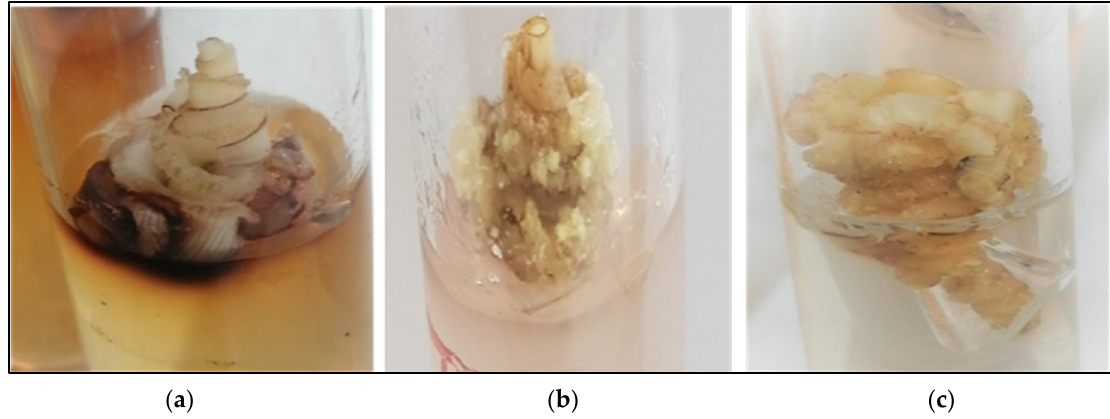
Figure 4. Callus of CP-77-400 on MS + 5 mg L − 1 2,4-D after 10 ( a ), 20 ( b ), and 30 ( c ) days of inoculation (2 × ).